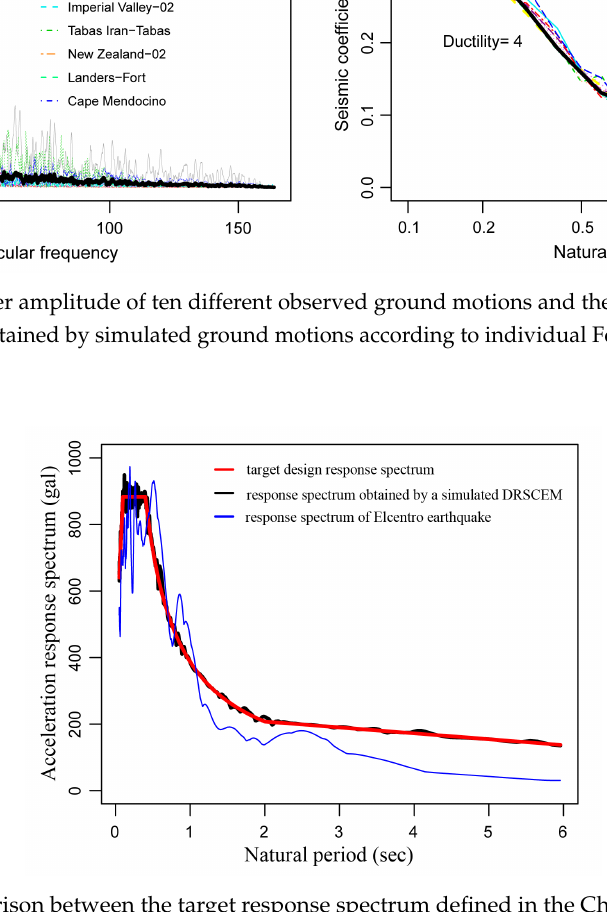
Figure 10. Comparison between the target response spectrum defined in the Chinese seismic design code of GB50011-2010 (red line) and recalculated spectrum by using a DRSCEM (black